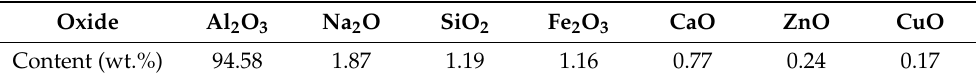
Figure 3. ( a ) XRD patterns of SAD before and after HCl leaching; ( b ) leaching rate of Al element by different concentrations of HCl. Table 2. XRF analysis of as-synthesized Al(OH) 3 powders from SAD.